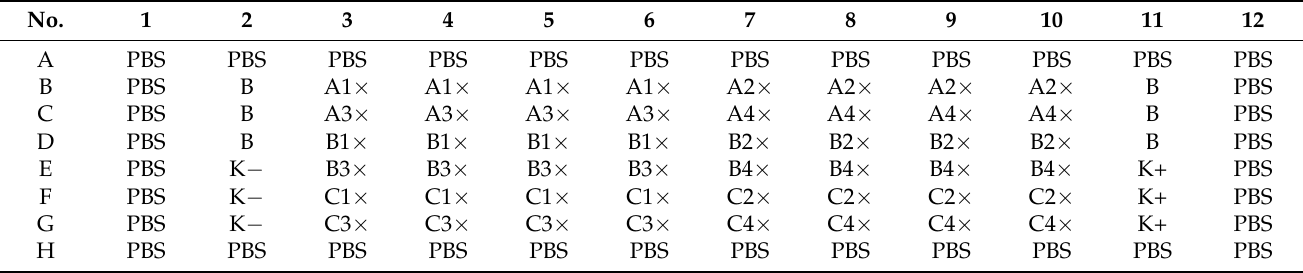
Table 7. Schematic design of a 96 well microplate used for examination of extracts of the three types of cured epoxy